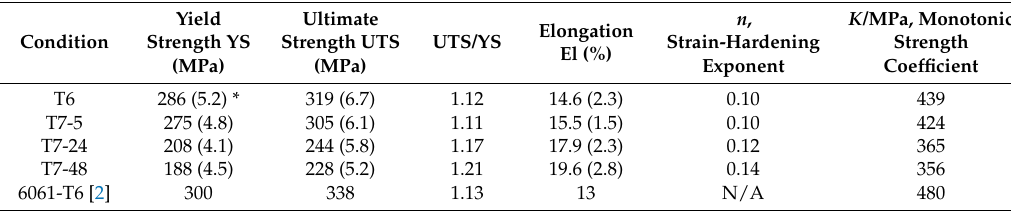
338 1.13 13 N/A